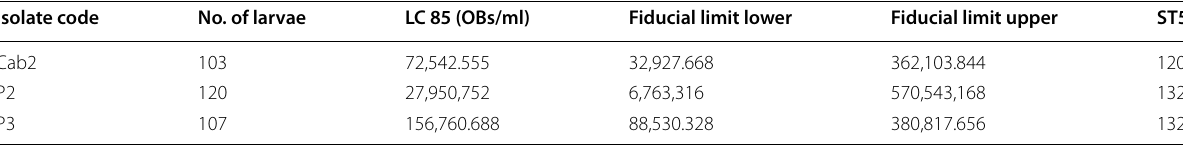
Table 2 ST50 values of the first instar Spodoptera littoralis larvae infected by S. littoralis NPVs Isolate